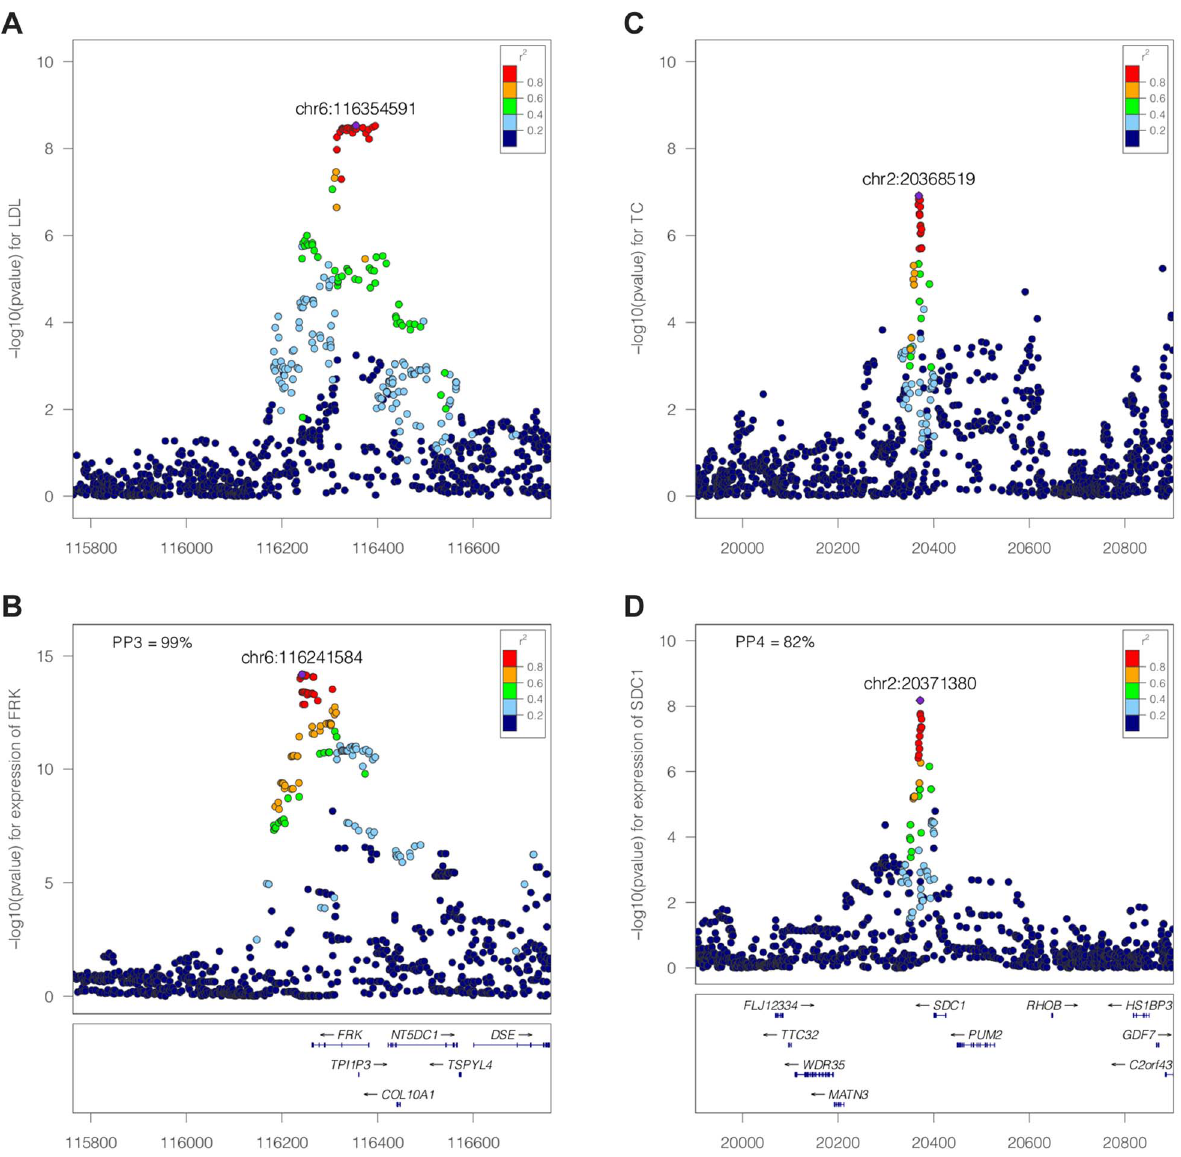
Figure 2. Illustration of the colocalisation results. Negative [SPACE] (A–B, FRK gene and LDL, PP3 . 90%) and positive (C–D, SDC1 gene and total cholesterol, PP4 . 80%) colocalisation results. 2 log10(p) association p-values for biomarker (top, A and C) and 2 log10(p) association p-values for expression (bottom, B and D) at the FRK (A, B) and SDC1 locus (C, D), 1Mb range.